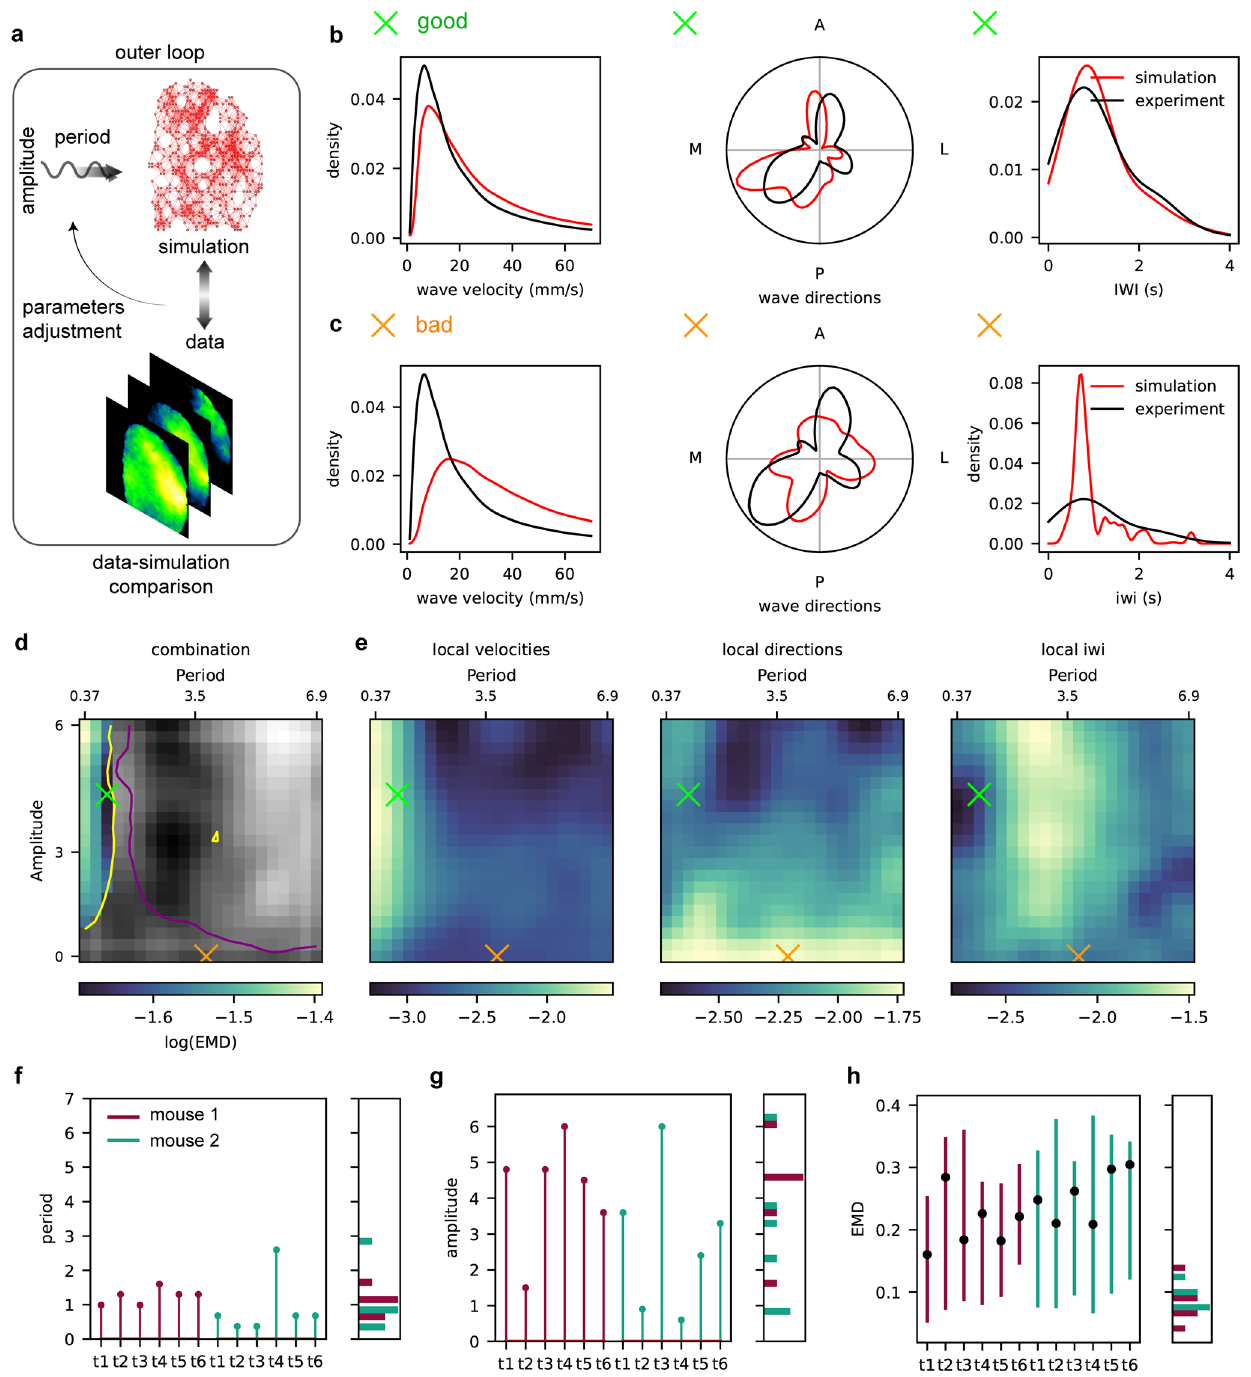
Fig. 4 Outer Loop. a The second step of the inference method consists in comparing simulations and data, to optimize neuro-modulation amplitude and period hyper-parameters. Here, we have a bi-directional fl ow of information from data to model and the other way round. b Direct comparison of the distributions of velocity (left panel), waves direction (central panel), and IWI (right panel) between data and simulation. The simulation is obtained selecting the optimal point (i.e. the minimum “ Combined Distance ” between experimental and simulated distributions) for the hyper-parameters grid search (amplitude and period of the neuro-modulation signal, see panel d ). c Same as panel b , but for a nonoptimal point of the grid search (see panel d ). d Results of the hyper-parameters grid search on a single trial. “ Combined Distance ” between simulated and experimental distributions (see text for details) is plotted as a function of the two hyper-parameters (amplitude and period). The gray area depicts the simulations rejected because of too long down-states (yellow line) or too short up-states (purple line), if compared with experimental distributions. The green cross depicts the optimum value, while the orange cross is a non-optimum, in fact corresponding to the inner-loop case (A = 0). e EMD between experimental and simulated distributions of velocities (left), directions (center) and IWI (right), for the same single trial of panel d . f , g Summary (across trials, and for the two different mice) of optimal hyper-parameter values obtained from the grid search, and their distribution (on the right). h Summary for the span between minimal and maximal “ Combined Distances ” for all the trials of the two mice, for the grid search in the same ranges of amplitude and period values of panel d . Black points refer to “ Combined Distance ” from the inner-loop simulation. On the right, the histogram of the lower bound of the EMD span is shown. COMMUNICATIONS BIOLOGY| (2023) 6:266